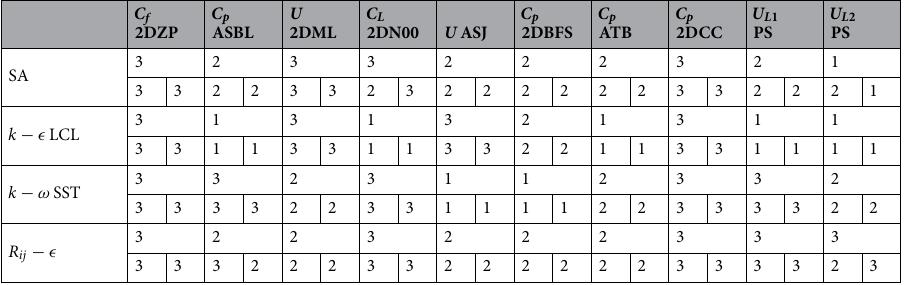
Table 1. Ratings of all RANS models for all QoIs. The STAR-CCM+ results are shown here. The NPHASE- PSU results and the CFL3D results are given in supplementary Table 1. Here, 3 is good, 2 is fair, and 1 is poor. The number in the top row is the training data, and the two numbers in the bottom row are the predictions. The first predicted rating is by the baseline recommender system, and the second is by the augmented system. We color the predictions red if they are different from the